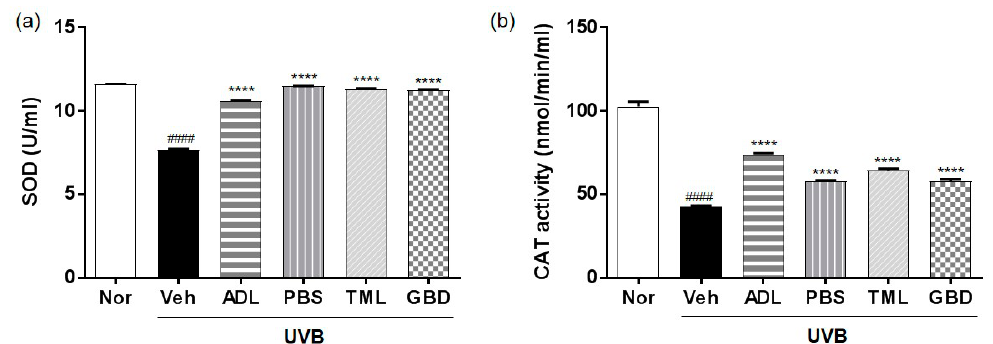
Figure 4. Effects of insect extracts on antioxidant activity with respect to ( a ) superoxide dismutase (SOD) and ( b ) catalase (CAT) in hairless mice skin exposed to UVB. #### p < 0.0001 vs. normal group, **** p < 0.0001 vs. vehicle group. These measurements were performed in triplicate. Nor, Normal; Veh, Vehicle; ADL, Allomyrina dichotoma larva; PBS, Protaetia brevitarsis seulensis ; TML, Tenebrio molitor Linnaeus; GBD, Gryllus bimaculatus De Geer.